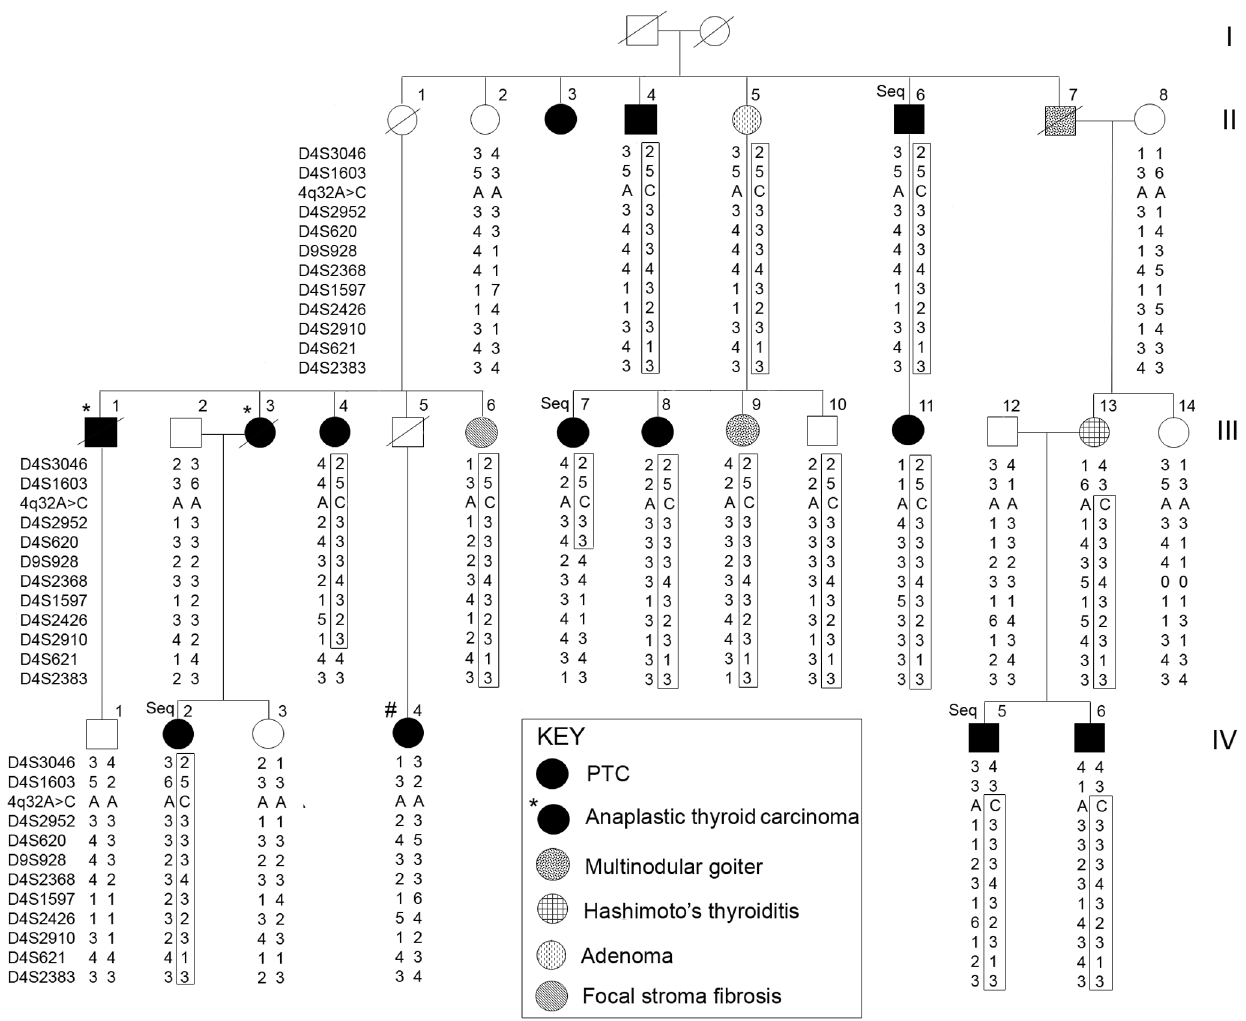
Figure 1. A thyroid cancer susceptibility locus in 4q32. Pedigree showing haplotypes of the family across the 4q32 region. The shared haplotype is boxed. The DNA samples from 4 affected individuals studied by targeted deep sequencing are marked ‘‘Seq’’. One PTC individual who does not share the haplotype and does not have the 4q32A . C mutation is marked ‘‘ # ’’.